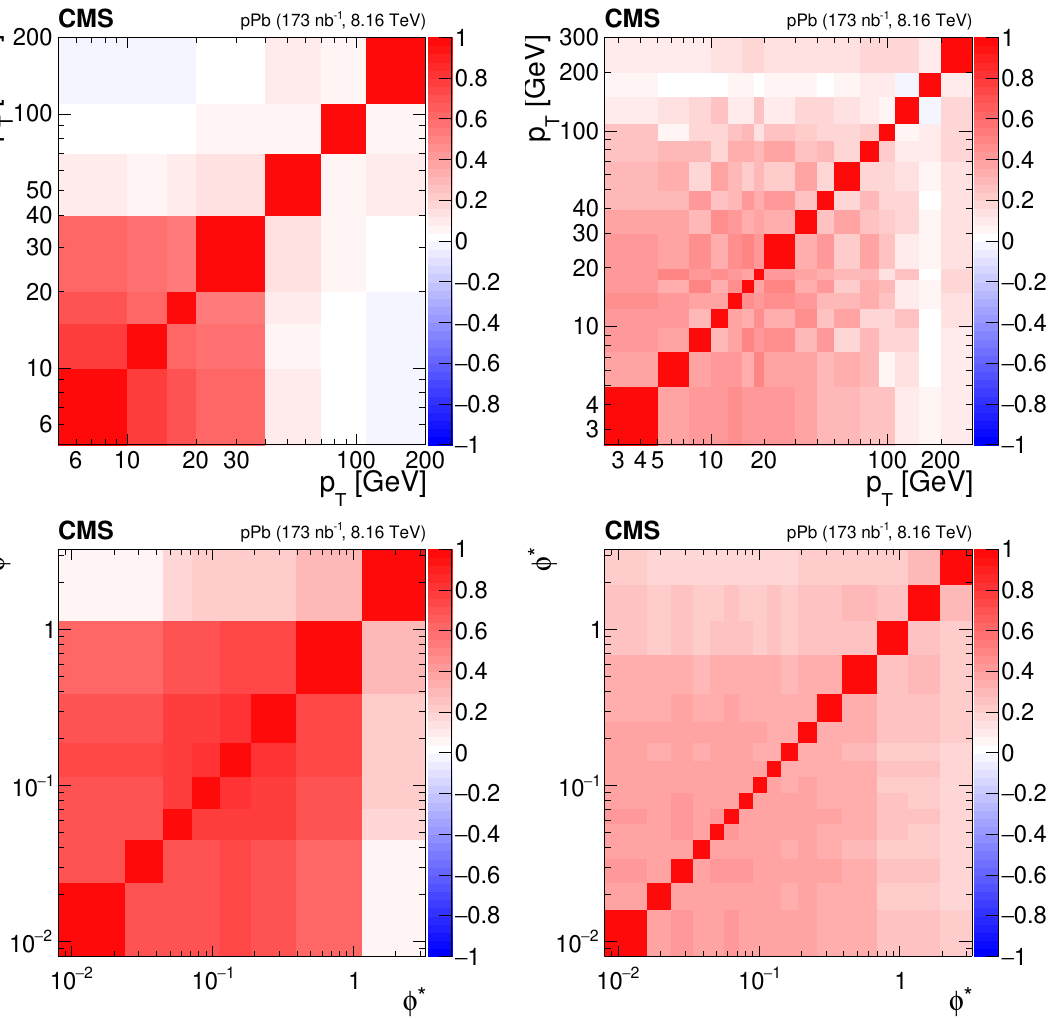
Figure 4 . Correlation matrices for the systematic uncertainties, excluding integrated luminosity, as functions of p (upper row) and φ ∗ (lower row), for 15 < m T 120 GeV